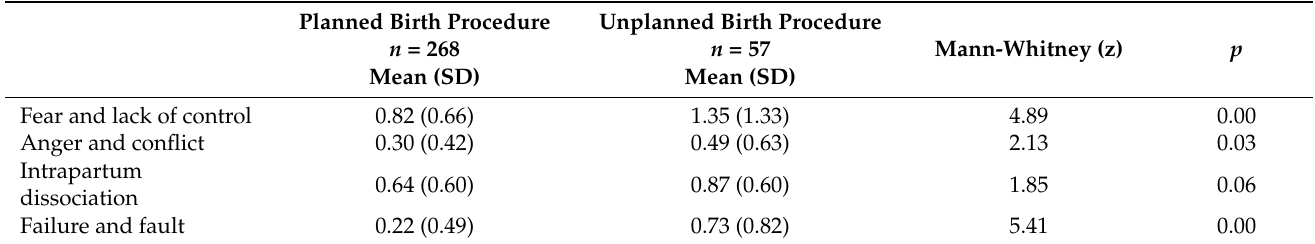
Table 5. Differences in negative emotions between women that experienced ‘planned’ birth versus ‘unplanned’